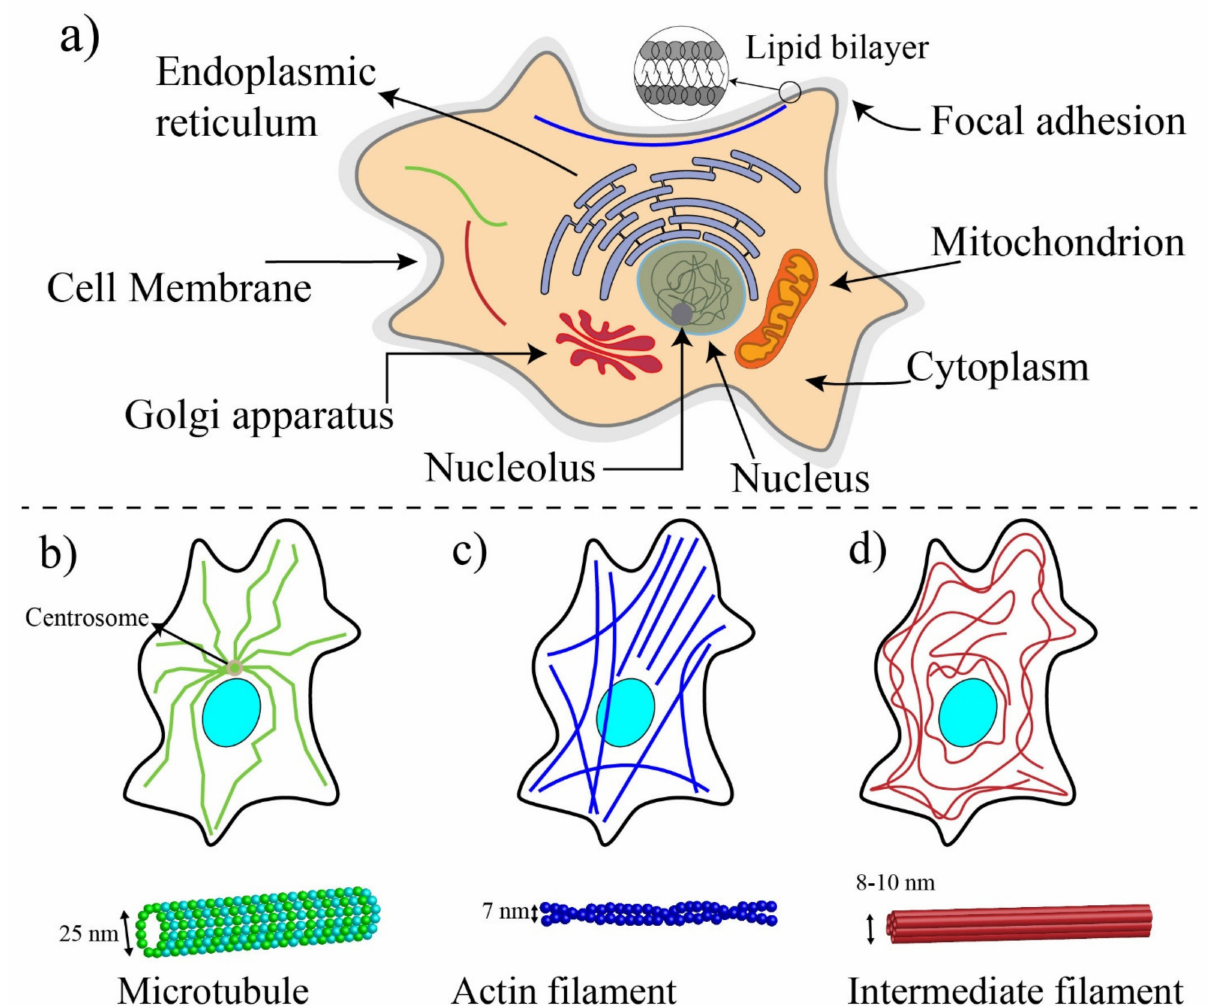
Figure 3. ( a ) Schematic showing typical eukaryote cells, ( b ) microtubules (they are in curved format), ( c ) actin filaments or long stress fibers (they are in linear format), and ( d ) intermediate filament (they are extending from the nucleus to the periphery of